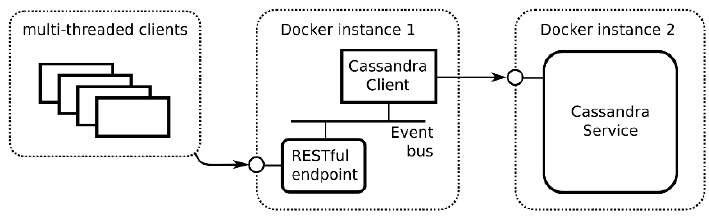
Figure 13. Setup of the numerical experiment — traffic from TSICUs to a TTICU.